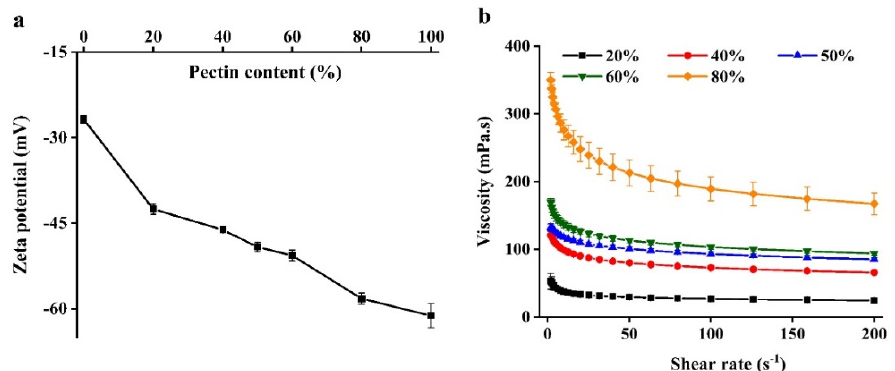
Figure 1. The zeta-potential ( a ) and apparent viscosity ( b ) of beads formation solutions used to prepare the hydrogel beads.